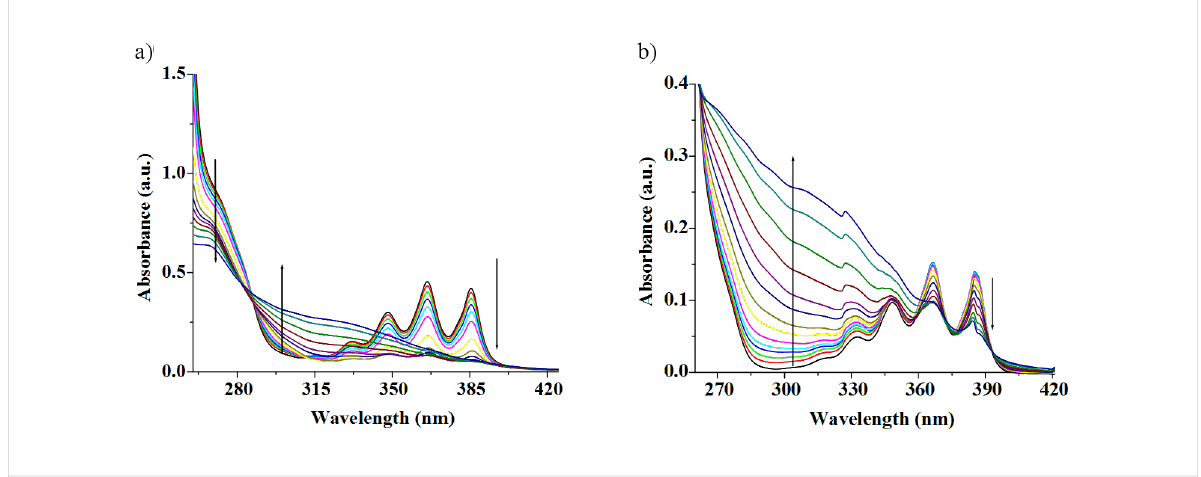
Figure 9: a) Absorption spectra of receptor 1 ( c = 5.09 × 10 − 5 M) upon gradual addition of Cu 2+ ion ( c = 1.4 × 10 − 3 M) in CH 3 CN containing 0.02% DMSO; b) absorption spectra of receptor 2 ( c = 1.48 × 10 − 5 M) upon gradual addition of Cu 2+ ion ( c = 4.4 × 10 − 4 M) in CH 3 CN containing 0.1% DMSO.